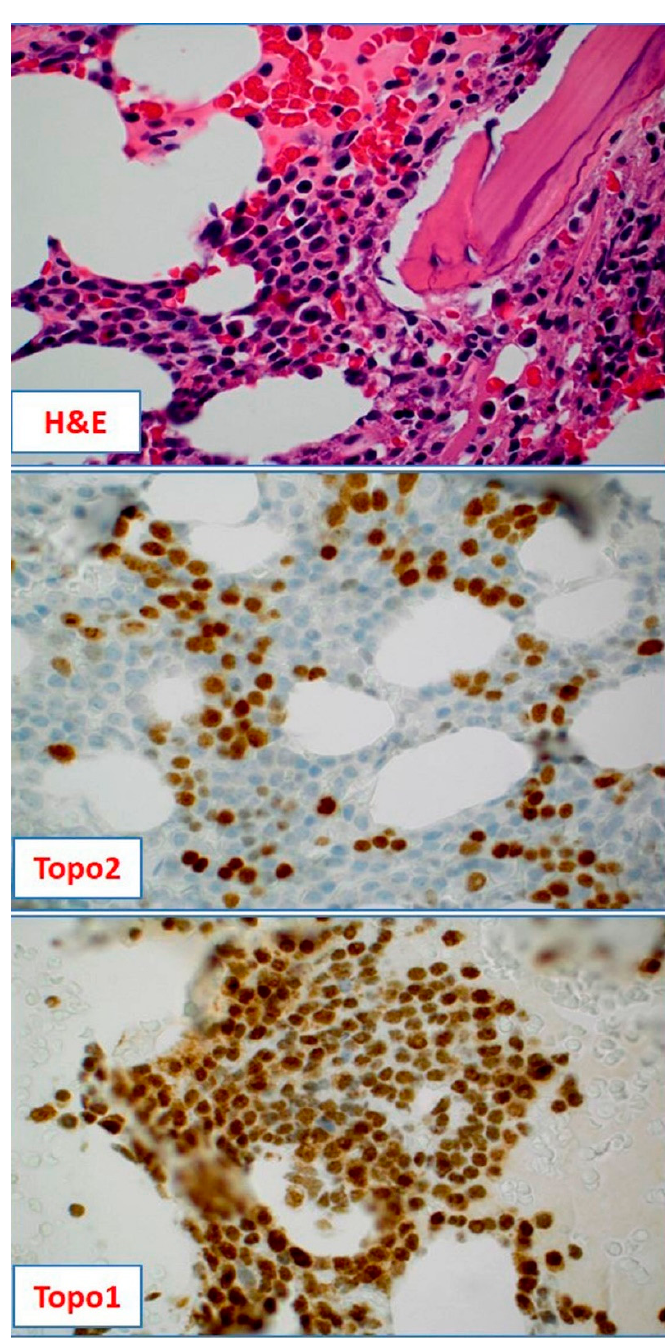
Figure 3. Hematoxylin-Eosin (H&E) staining of a bone marrow biopsy from a relapsed and heavily pretreated multiple myeloma patient revealing a diffuse infiltration with neoplastic myeloma cells (10× magnification); the tumor cells were positive for Topo2 (40% of the cells positive) and Topo1 (90% of the cells positive) (20× magnification).